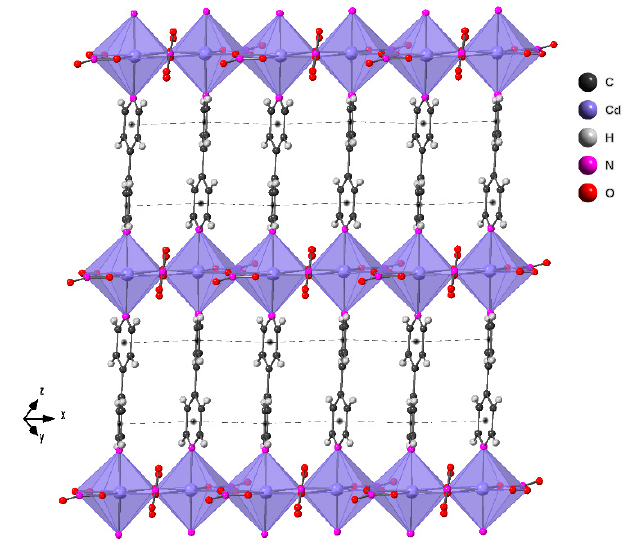
Figure 4. View of the layers of compound 2 . The black point into the pyridine rings represents the ring centroid and the dotted lines the π – π interactions stablished between adjacent aromatic rings.